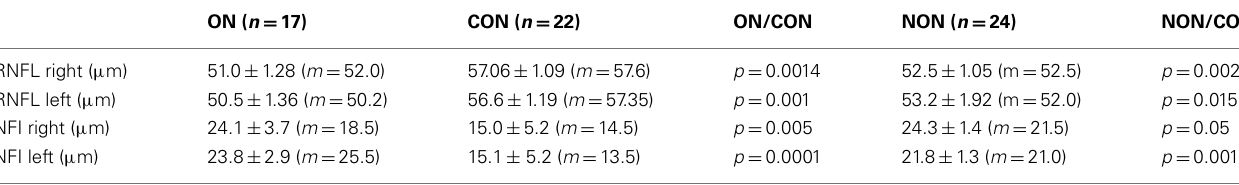
Table 5 | GDx RNFL in groups: ON, NON, and controls